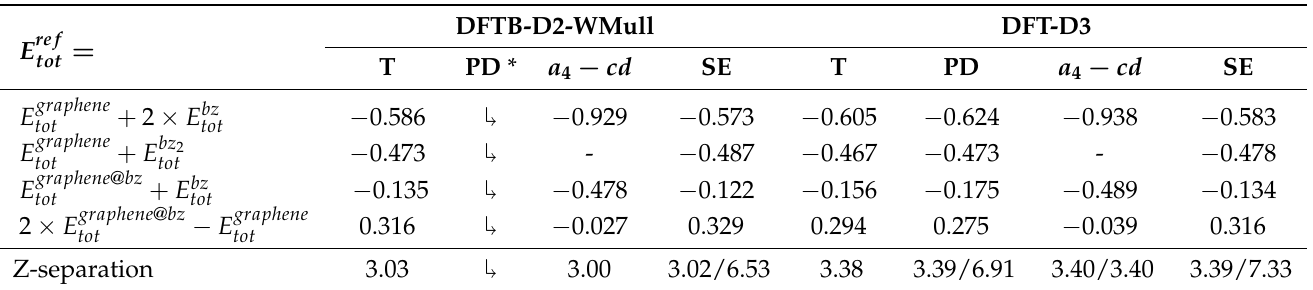
Table 5. Binding energy of benzene dimers bz 2 on graphene in eV and z-separation between the graphene sheet and the benzene units parallel to it in Å. * No value is reported at the DFTB-D2-WMull level for PD as the optimization resulted in the a 4 − cd